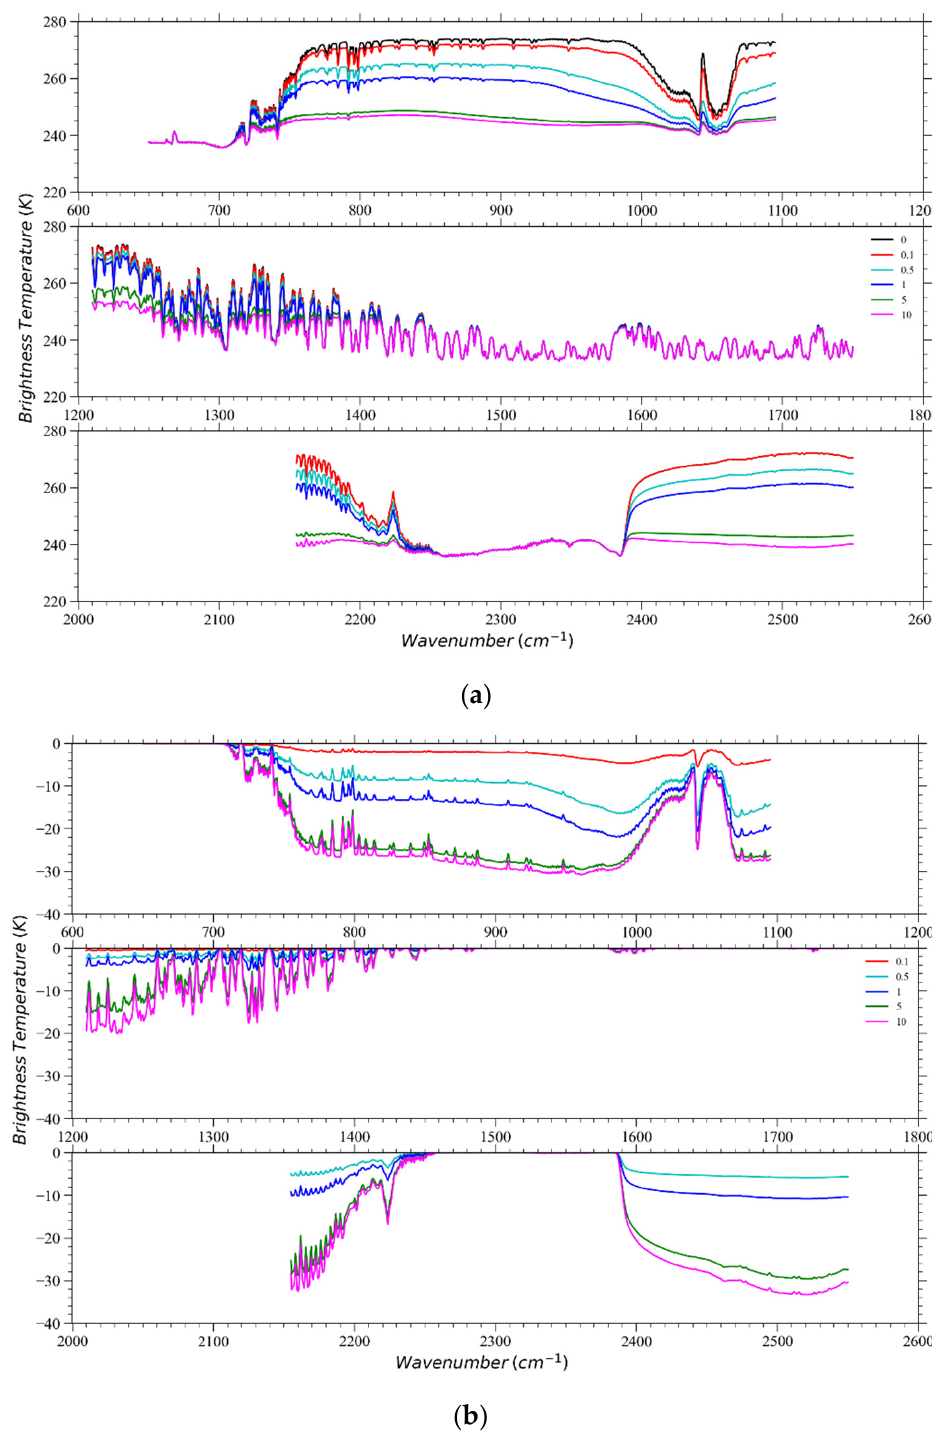
Figure 3. Simulated brightness temperatures ( a ) of the CrIS LWIR (upper panels), MWIR (middle panels), and SWIR (bottom panels) bands and the difference ( b ) between the clear condition and scaling of the concentration of the sand aerosol profile.